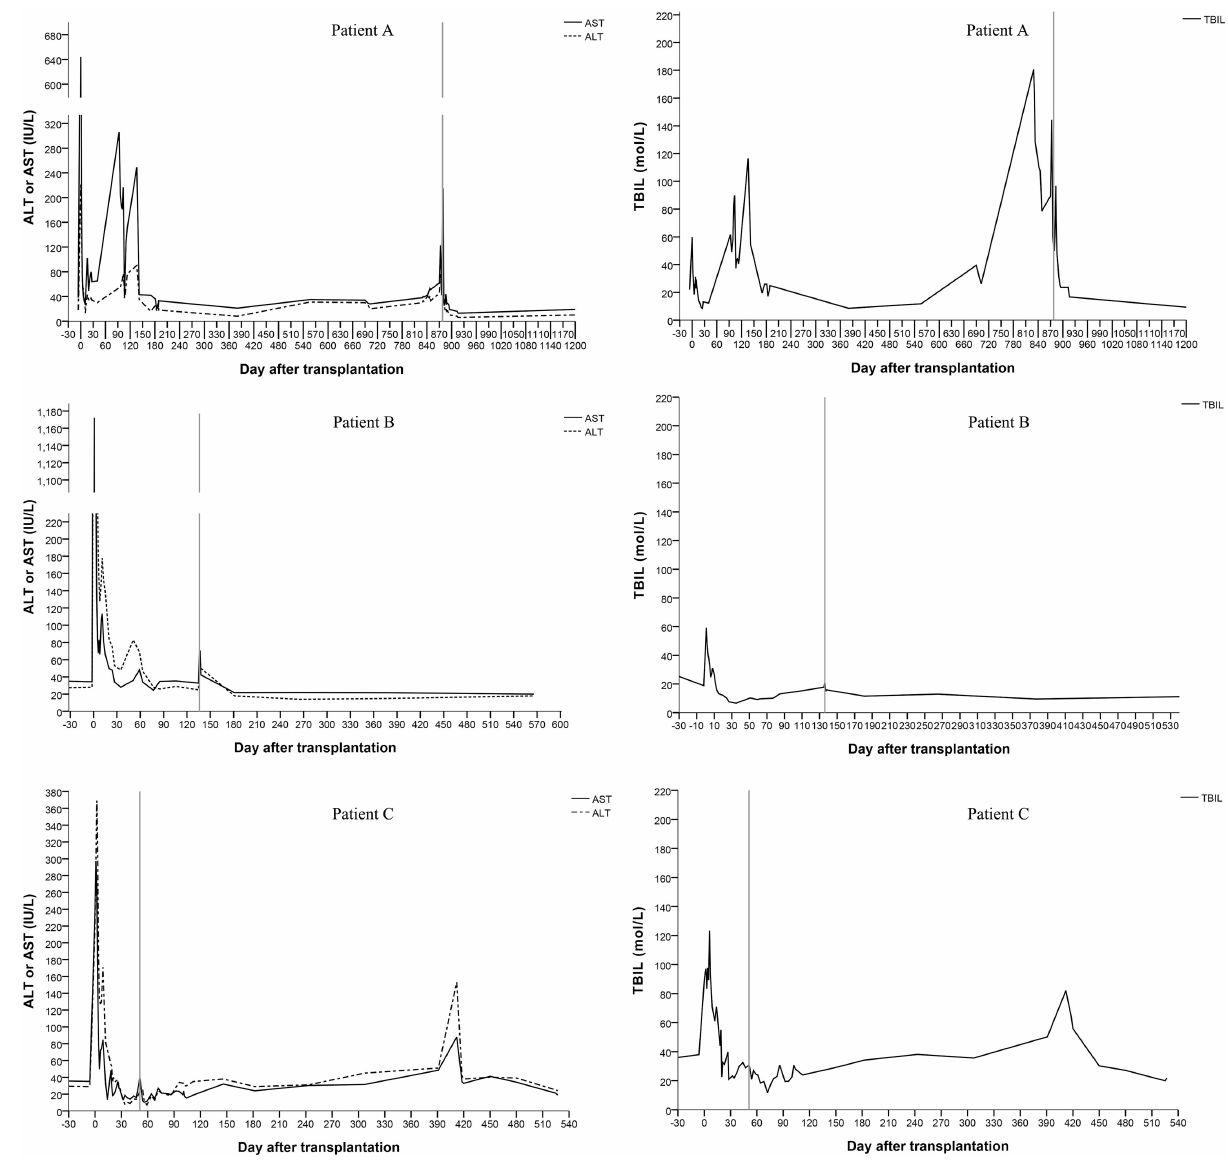
FIGURE 2 | Changes of the serum biochemical parameters for liver function (the vertical line shows the date of the hepatectomy of the remnant native